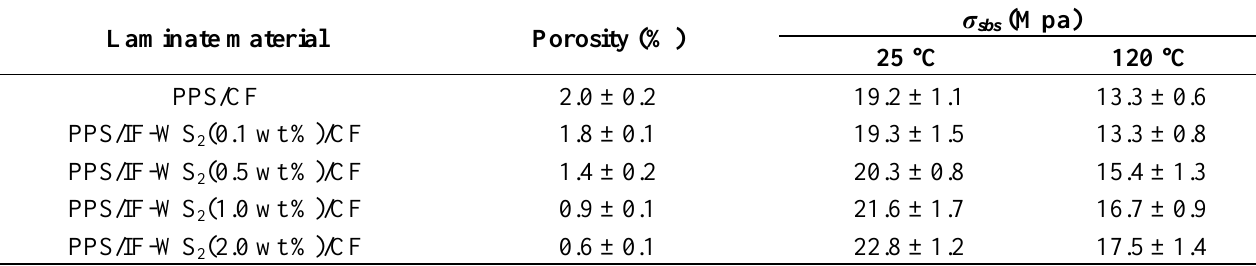
Table 1. Degree of porosity and short-beam shear strength σ 25 and 120